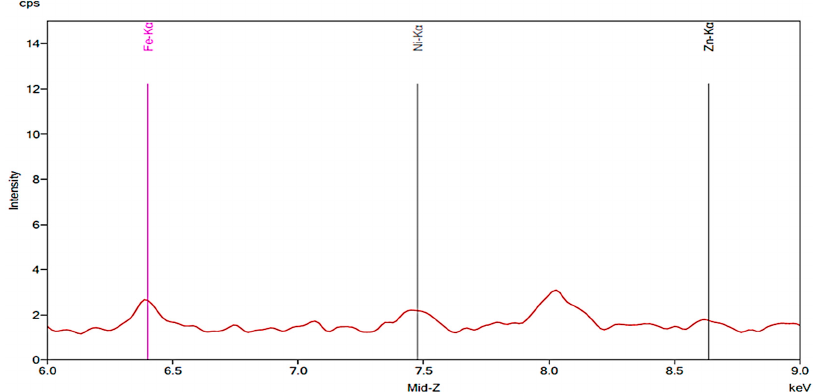
Figure 1. The results of the control group. The red peaks correspond to the baseline of the new artificial teeth prior to exposure to water. Markers are shown for iron, nickel and zinc. The green peaks represent the same artificial teeth following exposure to tap water for 24 h.